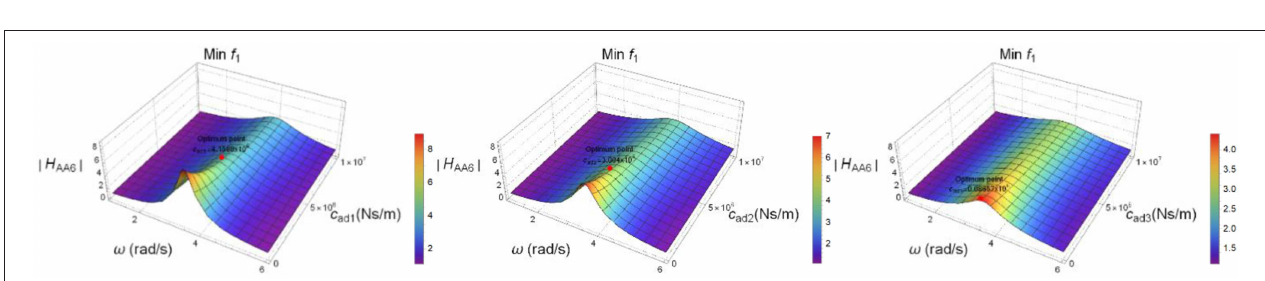
H AA6 based on f 1 minimization with respect to excitation frequency and added damping parameters. (cid:12) (cid:12) (cid:12) (cid:12)